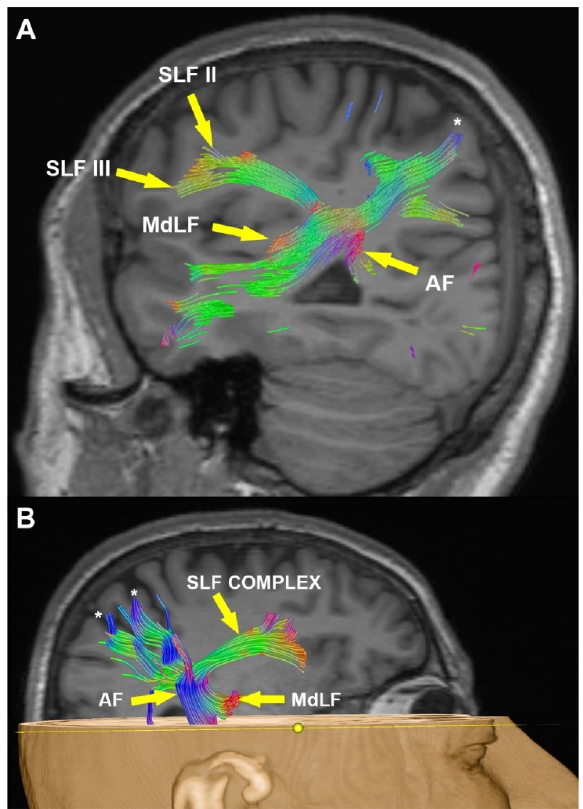
Figure 2. Sagittal ( A ) and 3D volume rendered ( B ) view of T1 weighted MR image with fused tractography show the complex course of AF, SLF II, SLF III and MdLF together (arrows). Note the superior oblique course of MdLF to the precuneus (asterisks). SLF II and III fibers together marked as “SLF